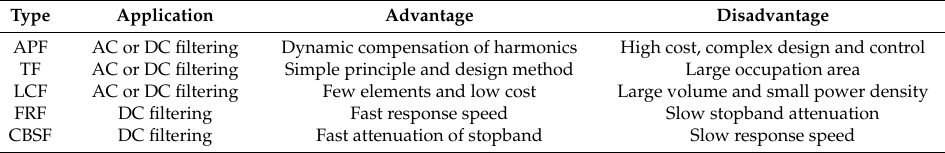
Table 1. Characteristic comparison of different filters.